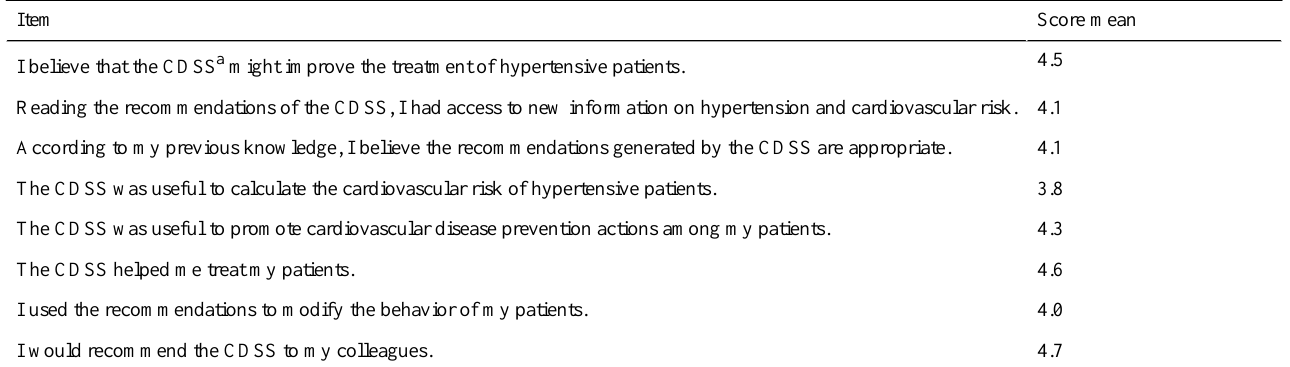
Table 5. Utility score on a 5-point scale by item